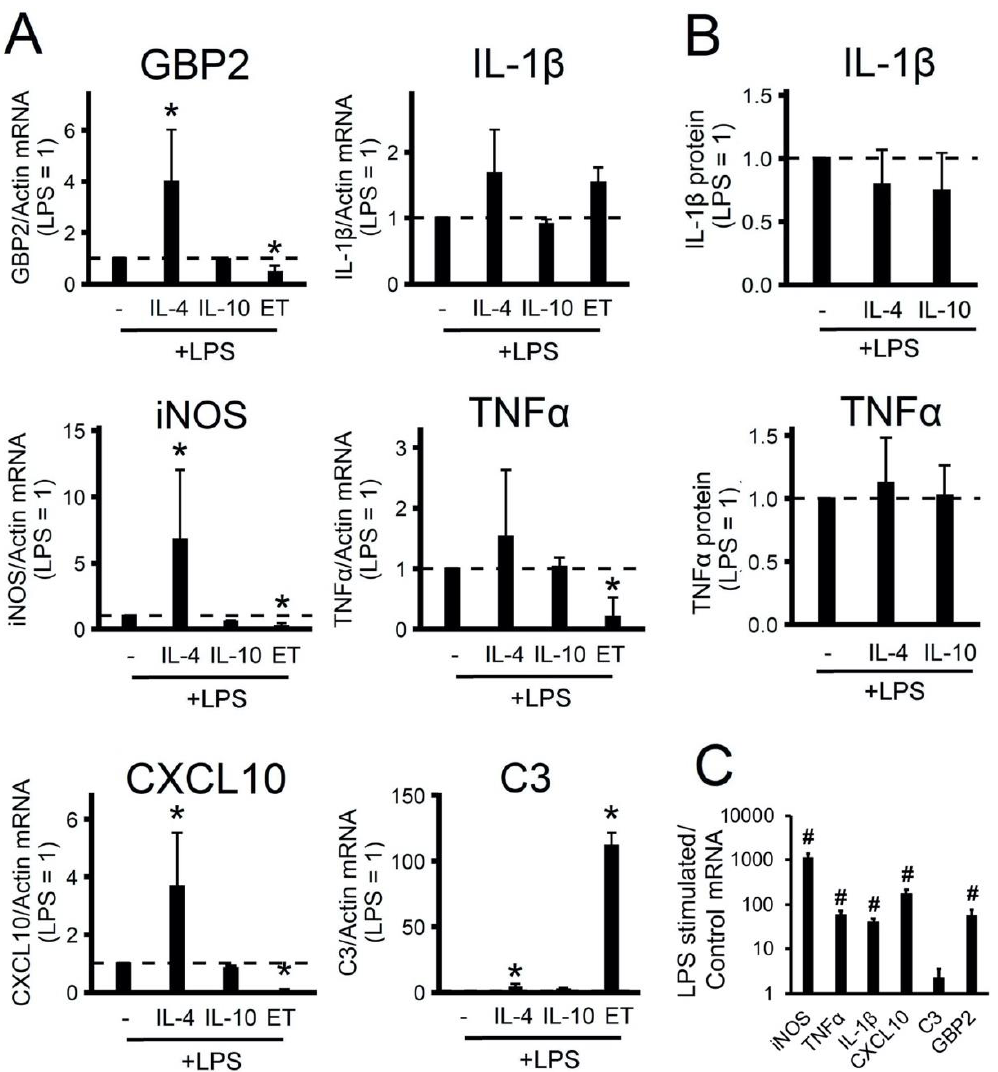
Figure 2. Effects of polarized astrocytes on the inflammatory response. The primary rat astrocyte cultures were pretreated with IL-4 (10 ng/mL) or IL-10 (20 ng/mL) for 24 h or adapted to endotoxin in the tolerance model (LPS 10 ng / mL, 48h, ET) and then stimulated with LPS (100 ng / mL) for 4h (the level of gene expression under LPS stimulation is shown by the dotted line). ( A ), ( C ): the mRNA levels were determined by real-time RT-PCR. The values are normalized to β -actin mRNA levels. ( B ): the TNF α and IL-1 β protein release measured by ELISA in supernatant samples. The results are expressed as fold-changes, relative to the LPS-stimulated cells. ( C ): the results are represented as lg, relative to the control cells. The values represent a mean ± SEM from three independent experiments. * p < 0.05, compared with the LPS-stimulated cells, # p < 0.05, compared with the unstimulated